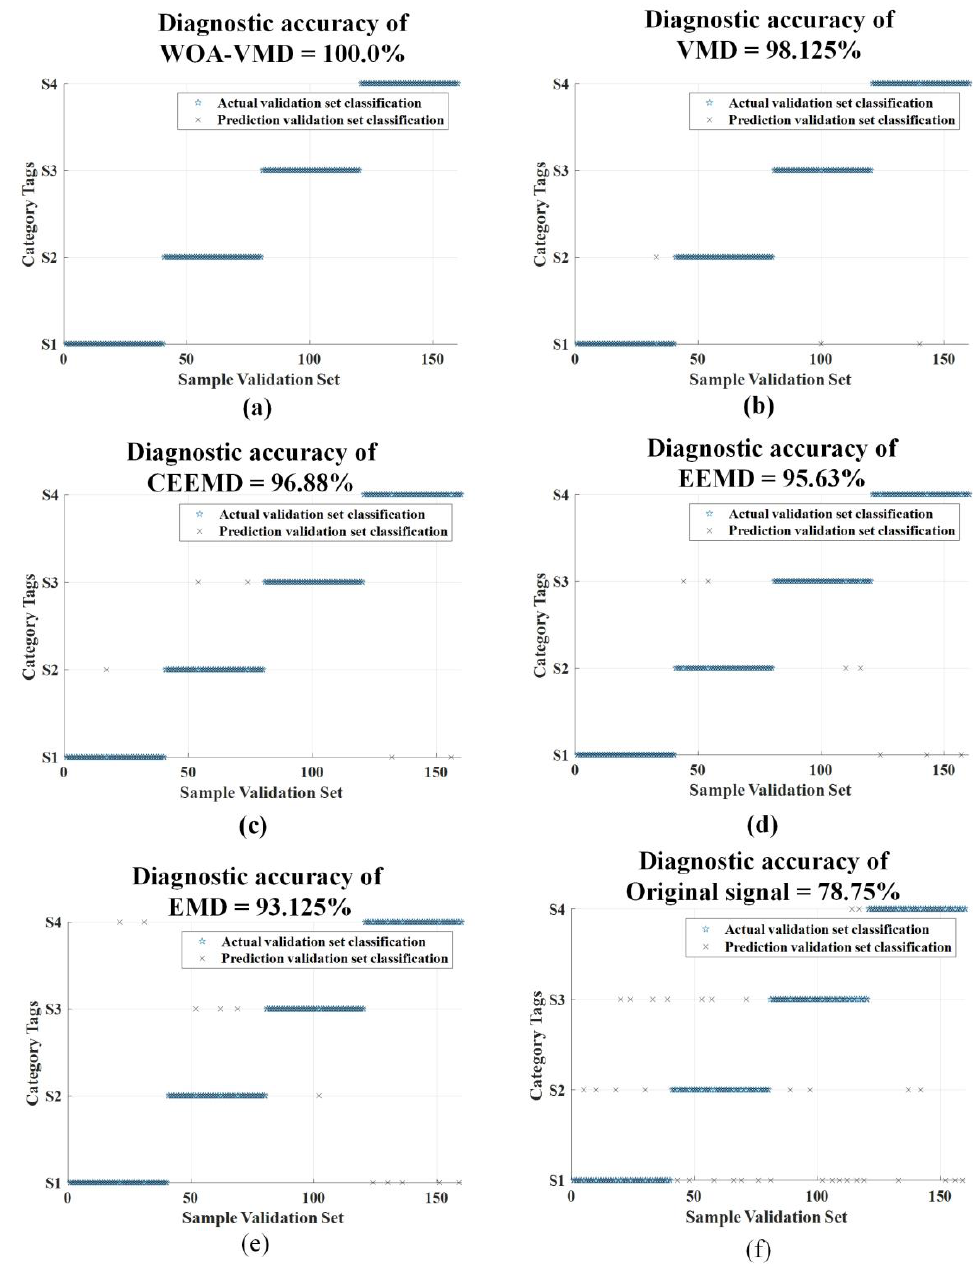
Figure 14. Comparative analysis of diagnostic results of different noise reduction methods: ( a ) WOA-VMD = 100.0%; ( b ) VMD = 98.125%; ( c ) CEEMD = 96.88%; ( d ) EEMD = 95.63%; ( e ) EMD = 93.125%; ( f ) original signal = 78.75%.